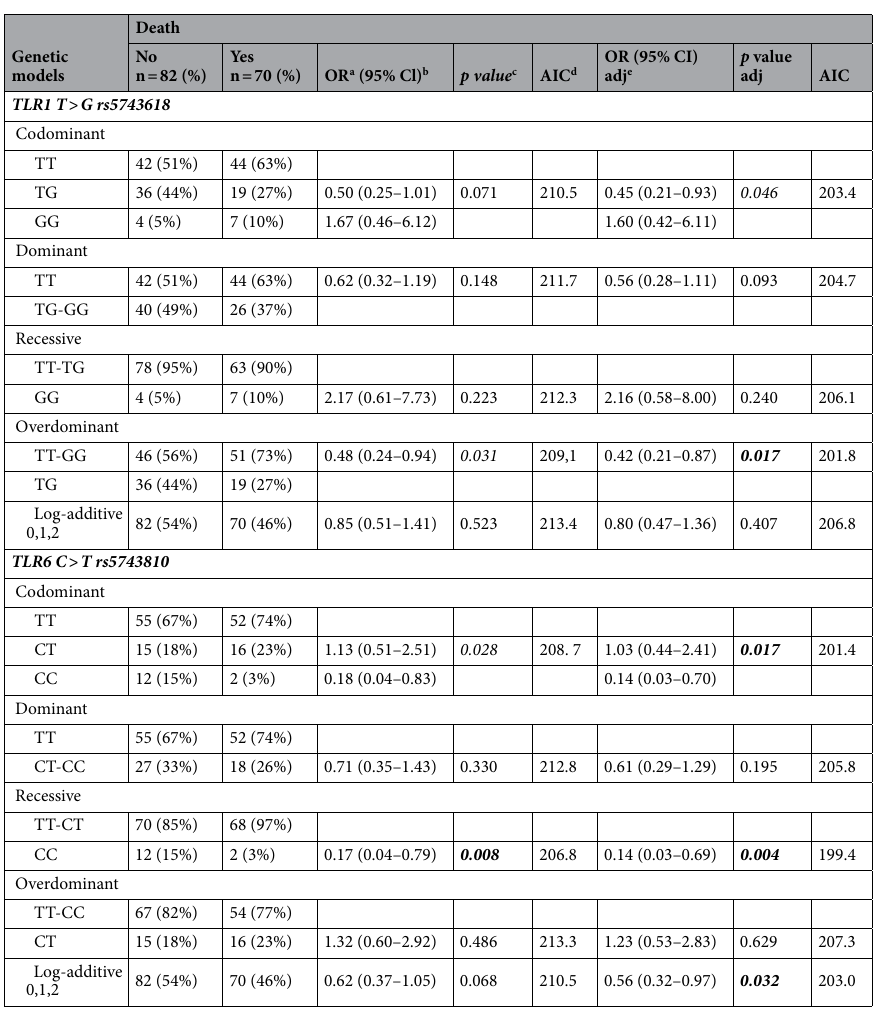
Table 3. Analysis of the association of single nucleotide polymorphisms (SNPs) in study with the risk of death in acute lymphoblastic leukemia patients. a OR: Odds Ratio; b 95% confidence interval; c p value: < 0.05; d AIC: Akaike information criterion value; e Adj: Adjusted for sex and age. Significant values are in